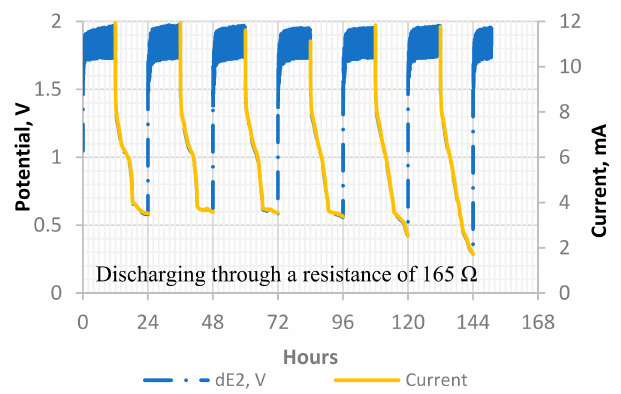
Figure 12. Six charge and discharge cycles of the Ni–Fe concrete battery, through a resistance of 165 Ω . The cell potential is represented by dE2, which is the potential difference between the Ni cathode and the Fe